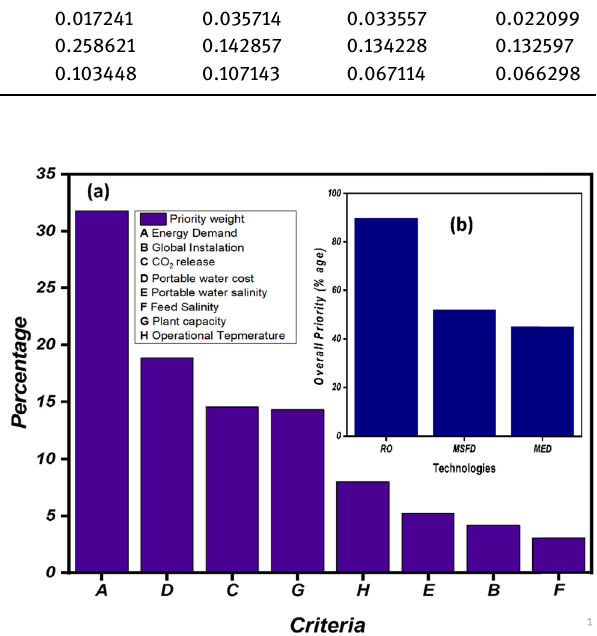
Figure 5: Consolidated results of the AHP ( a ) priority weightage of parameters ( b ) overall priority weightage of compared